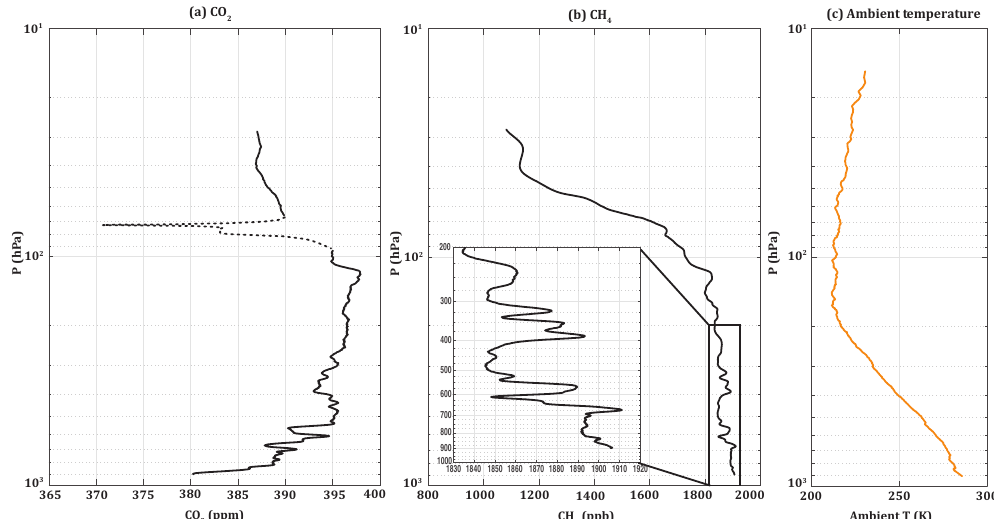
Figure 8. Vertical profiles retrieved from the air sampled with AirCore-HR on the EdS-Stratéole flight on 29 August 2014: (a) CO 2 (ppm), (b) CH 4 (ppb) and (c) ambient temperature (K). The dotted line in the CO 2 profile corresponds to a part of the profile with unrealistic CO 2 values due to flight trajectory (see